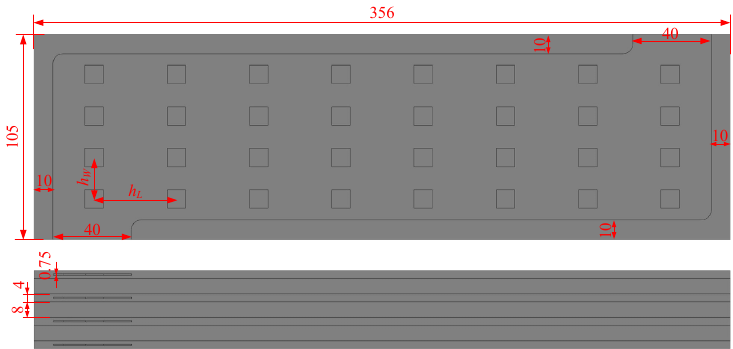
Figure 3. Cooling plate geometric structure.